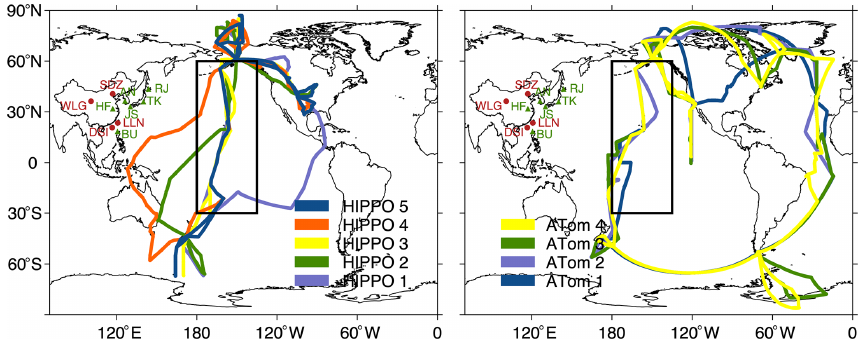
Figure 1. Locations of NOAA surface sites (red circles), TCCON sites (green triangles) in China, and aircraft flight tracks of HIPPO and ATom